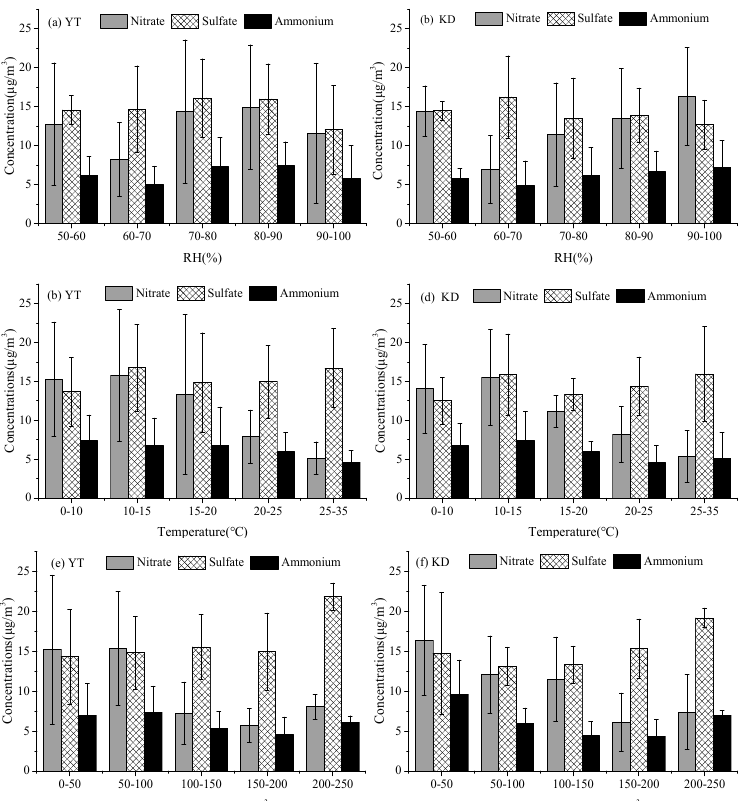
Figure 4. Comparisons of ions concentration in PM 2.5 at the YT and KD sites for different ranges of meteorological factors: ( a , b ) relative humidity; ( c , d ) temperature; ( e , f ) O 3 concentration. Table 3. Seasonal distribution of carbonaceous species over the three seasons at the YT and KD sites. YT KD Carbonaceous Spring